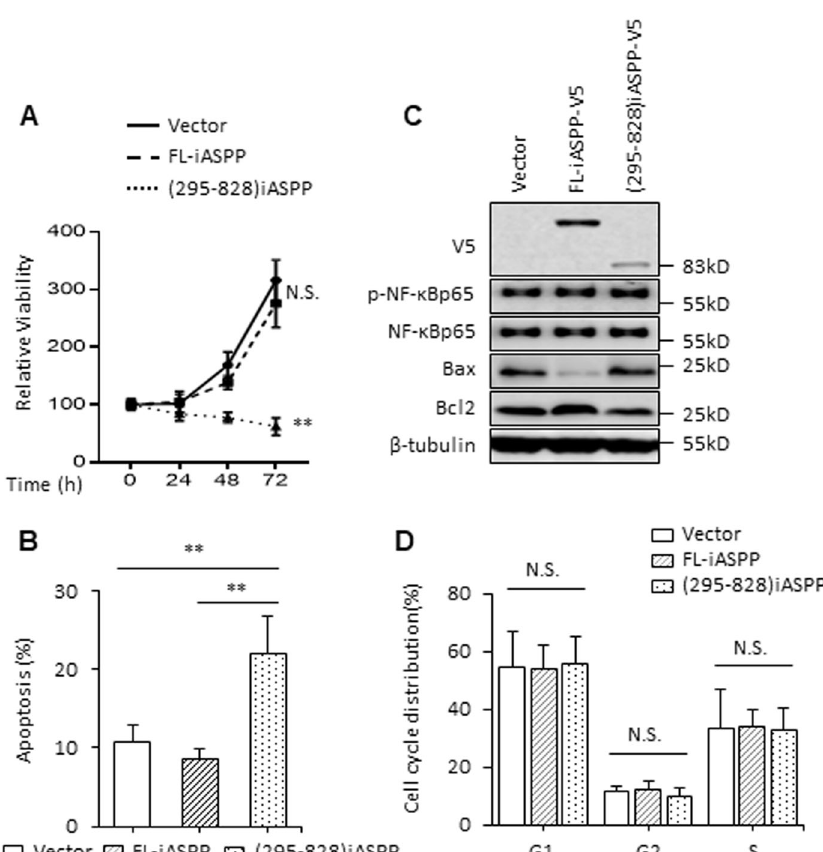
Fig. 3 The cleaved iASPP fragment promotes apoptosis in NF- κ Bp65 constitutively activated SK-BR3. A SK-BR3 cells were transfected with Vector, FL-iASPP, and (295 – 828) iASPP plasmids, then cell viability was revealed by MTT assay. ** p < 0.01, N.S. not signi fi cant. B Apoptosis levels were determined by Annexin V-FITC and PI staining in SK-BR3 cells after the indicated treatments. ** p < 0.01. C Bax, Bcl-2, p-NF- κ Bp65, and NF- κ Bp65 were determined by western blot in SK-BR3 cells. β -tubulin was used as an immunoblots loading control. D Cell cycle arrest was revealed by PI staining in SK-BR3 cells after the indicated treatments. N.S. not signi fi